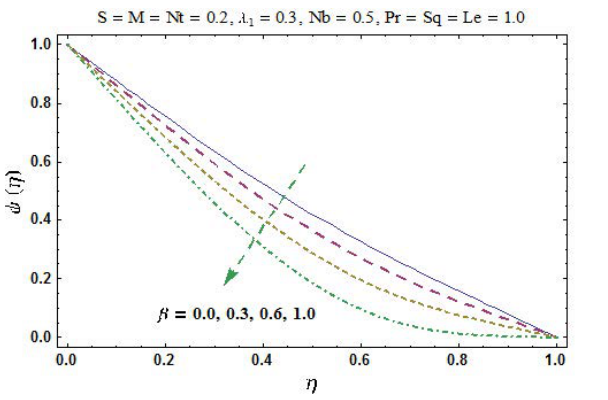
Figure 8. Plots of φ ( η ) for β